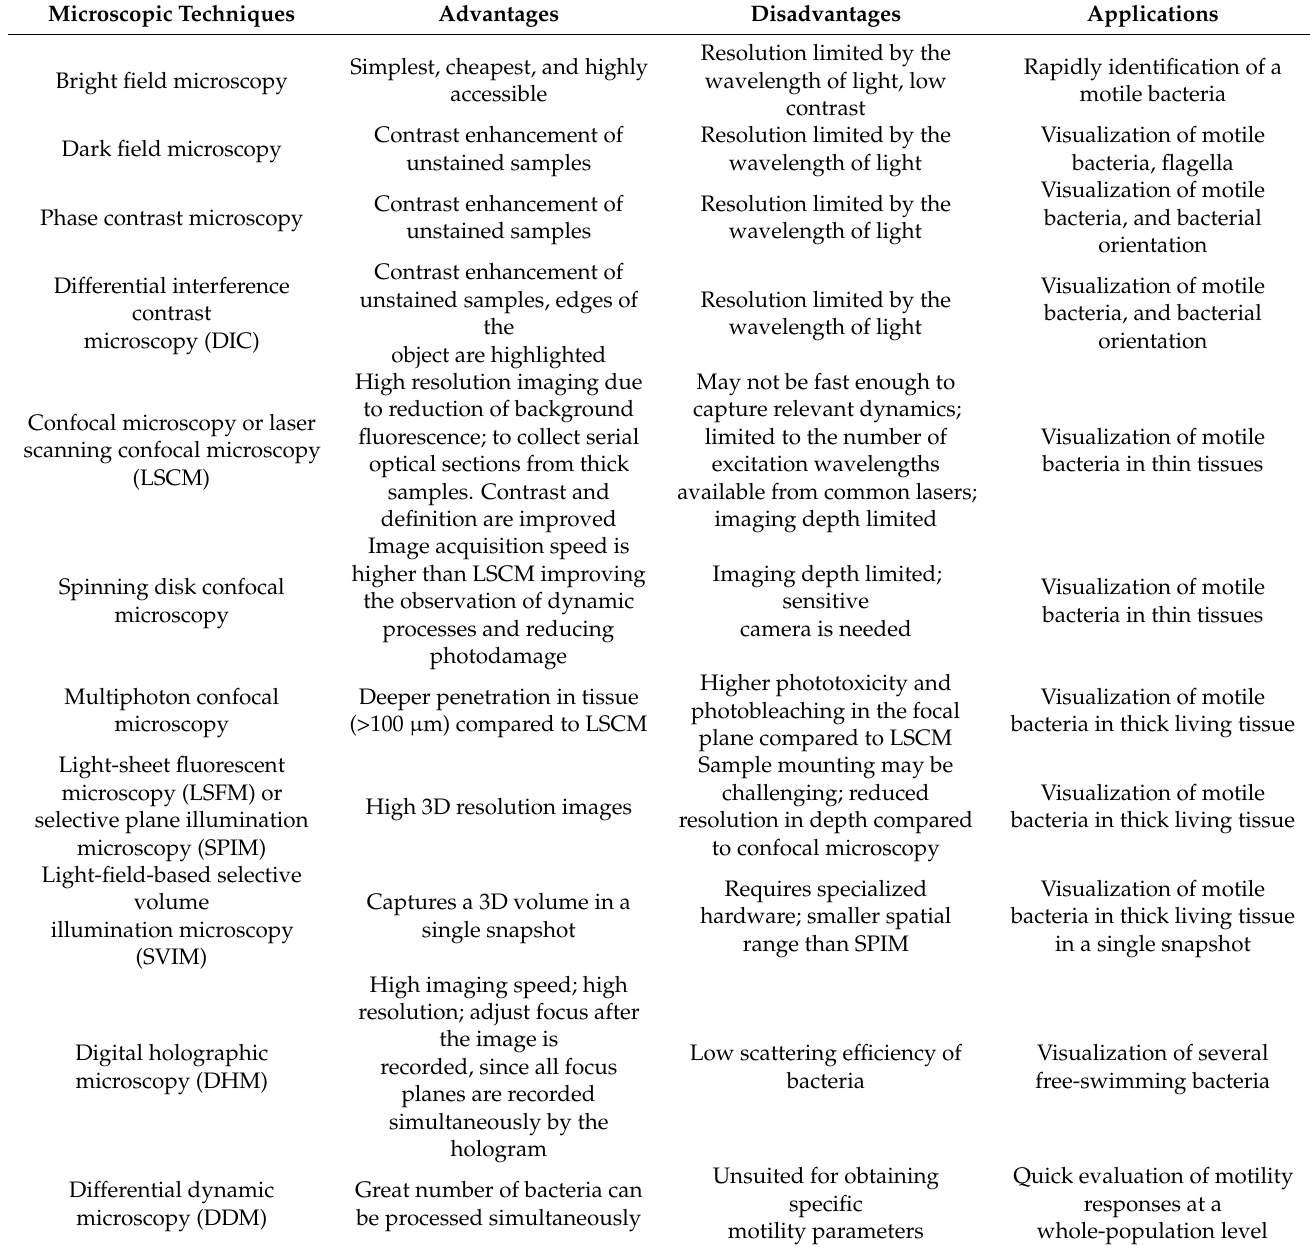
Table 3. Microscopic techniques to study bacterial motility and their main